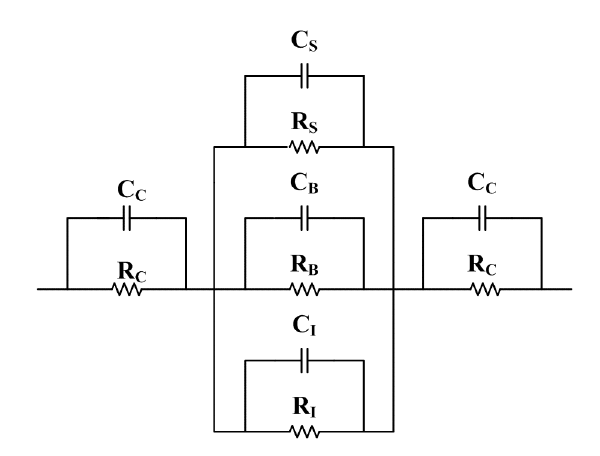
Figure 5. Equivalent circuit diagram of the device shown in Figure